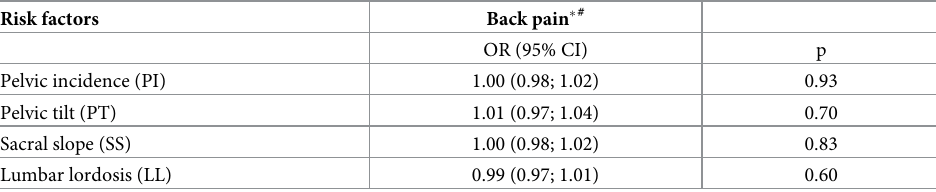
Table 6. Multivariable correlation of spinopelvic parameters with back pain.